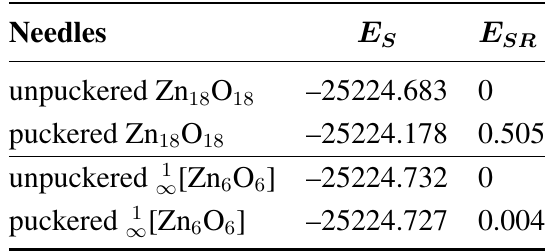
Table 2. Scaled energies ( E ) and relative energies ( E ), in eV, between unpuckered and S SR puckered needles, calculated with the PBE functional. For the lowest energy conformation, a relative energy of zero is